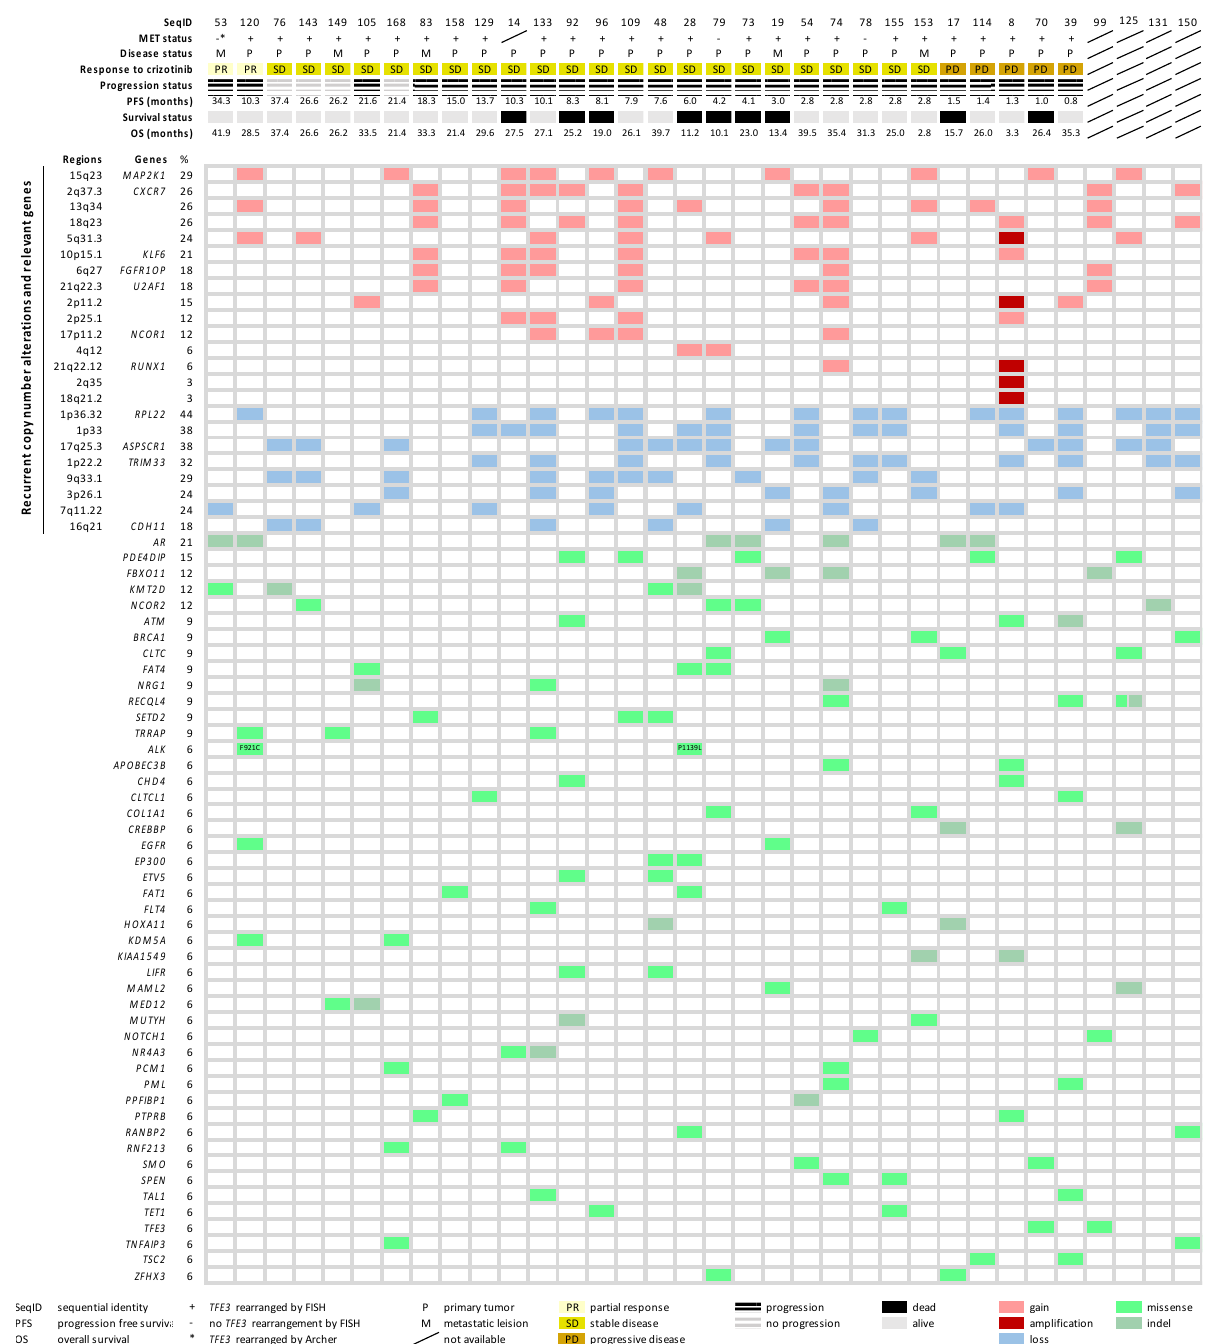
Figure 4. A summarized heatmap for the gene alteration landscape and trial-related clinical data. Clinical data for each case was listed on the top in the order of response to crizotinib. Types of alterations that affected genomic regions, as well as genes (cancer consensus gene associated genes), were sorted according to frequency. Rows represent individual regions and genes, while columns represent individual cases. Clinical features and types of alterations and are coded in different colors (bottom).